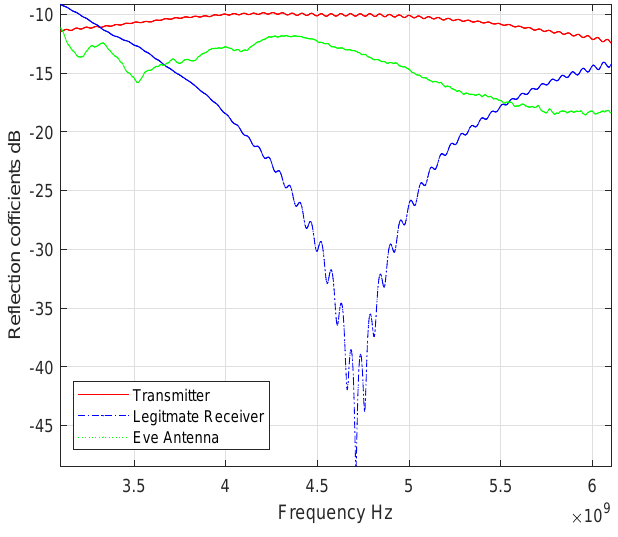
Figure 8. S-parameters of UWB